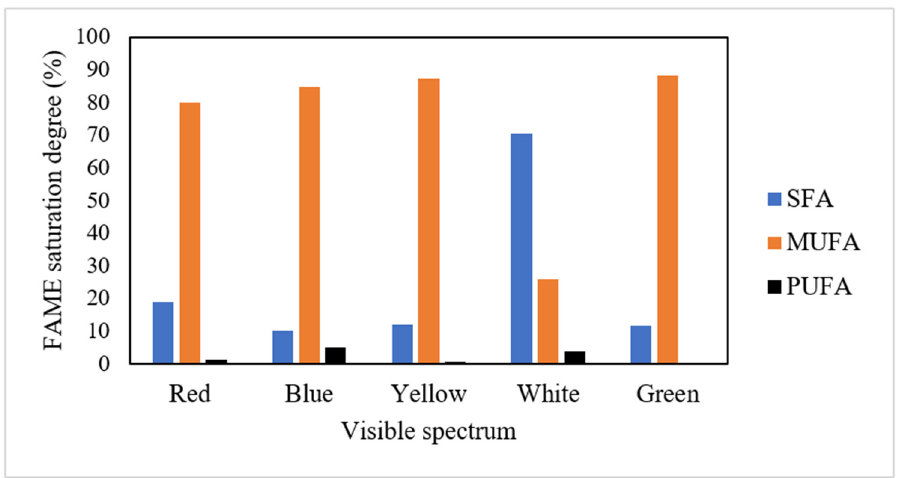
Figure 4. FAME saturation degrees of attached microalgae growing on palm decanter cake at vari- ous visible spectra of